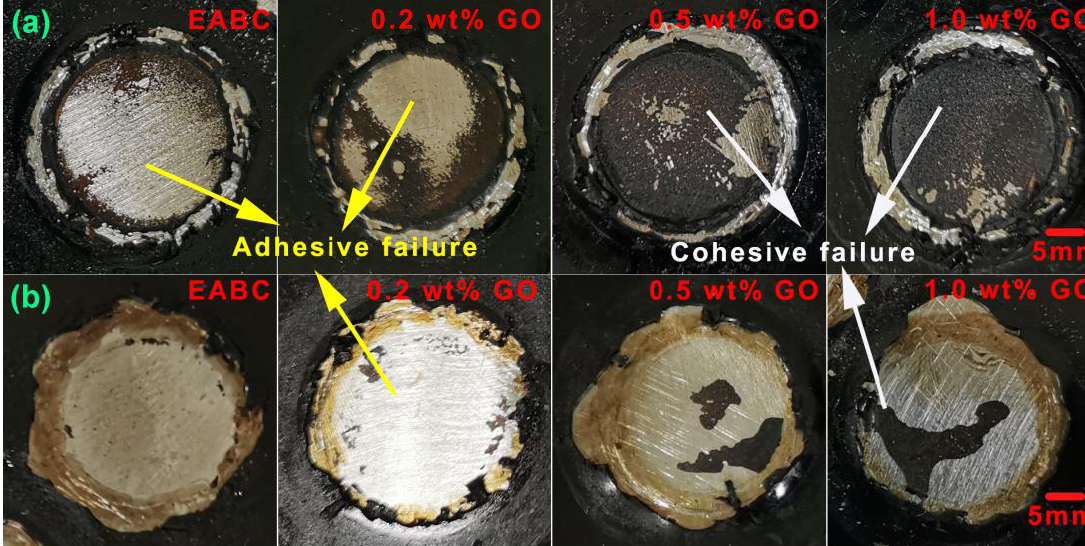
Figure 13. Failure surfaces of the unmodified and GO-modified EABCs on steel plates after pull-off tests at room temperature ( a ) and 60 °C ( b ).